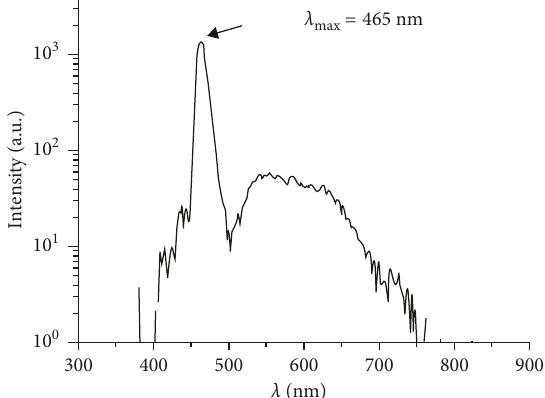
Figure 12: The photoluminescence spectrum of epitaxial layer of the solid solution (GaAs) 1 − x (ZnSe) x , at a temperature of